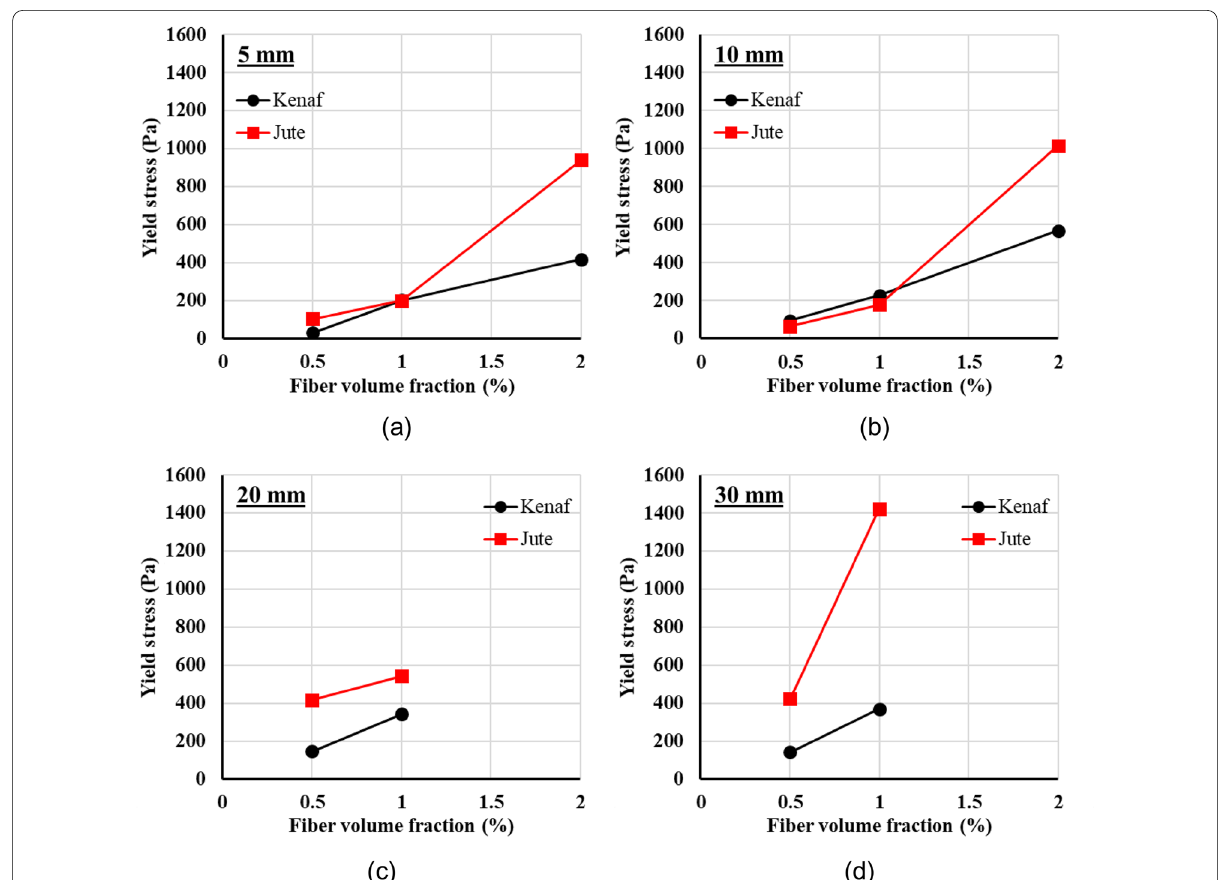
Fig. 10 Yield stress of NFRCCs versus the volume fraction of fibers of different lengths: a 5 mm; b 10 mm; c 20 mm; d 30